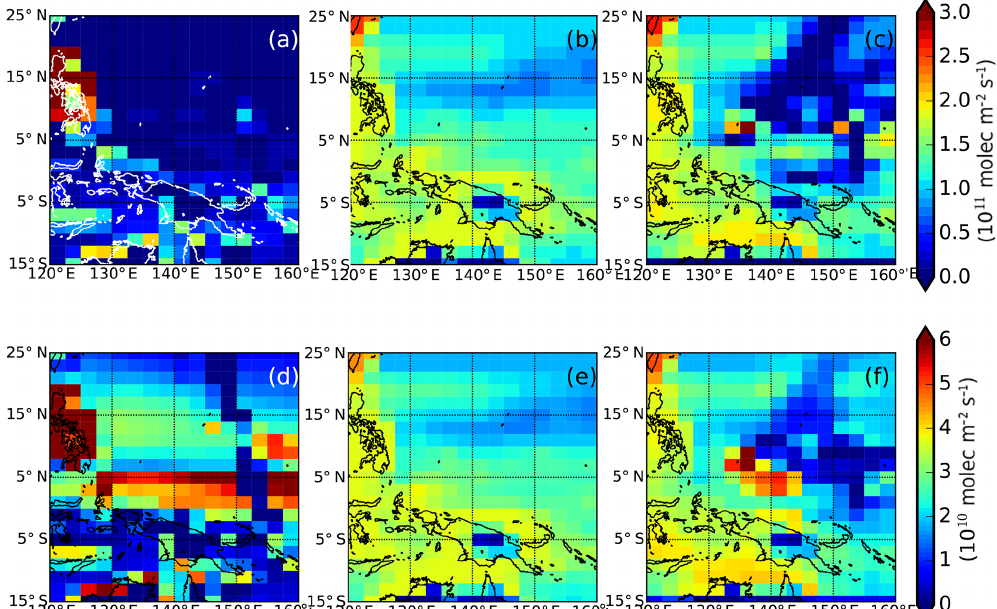
Figure 4. A priori and a posteriori surface fluxes of (top panels) CHBr 3 (10 11 molm − 2 s − 1 ) and (bottom panels) CH 2 Br 2 (10 10 molm − 2 s − 1 ) over the western Pacific study region. Panels (a) and (d) show the a priori fluxes we use in our MAP inversion (Or- dóñez et al., 2012); panels (b) and (e) show alternative bottom-up CHBr 3 and CH 2 Br 2 emission inventories (Ziska et al., 2013); and panels (c) and (f) show our a posteriori flux estimates inferred from CAST and CONTRAST